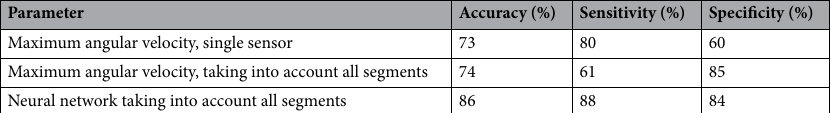
Table 5. Comparison of different methodologies for the analysis of rotation (the best results).